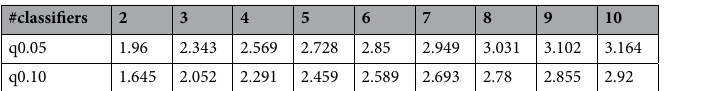
Table 6. Critical values for post-hoc tests after the Friedman test.